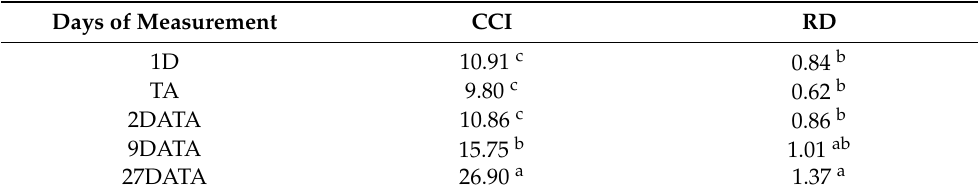
Table 3. Effects of time of measurements (days) on chlorophyll content index and dark respiration rate in maize leaves. CCI: chlorophyll content index, RD: dark respiration rate; in each column, values followed by different letters indicate statistically significant ( p ≤ 0.05) differences, initial measurement before stress (1D), treatments application (TA), 2 days after treatments application (2DATA), 9 days after treatments application (9DATA), 27 days after treatments application (27DATA).